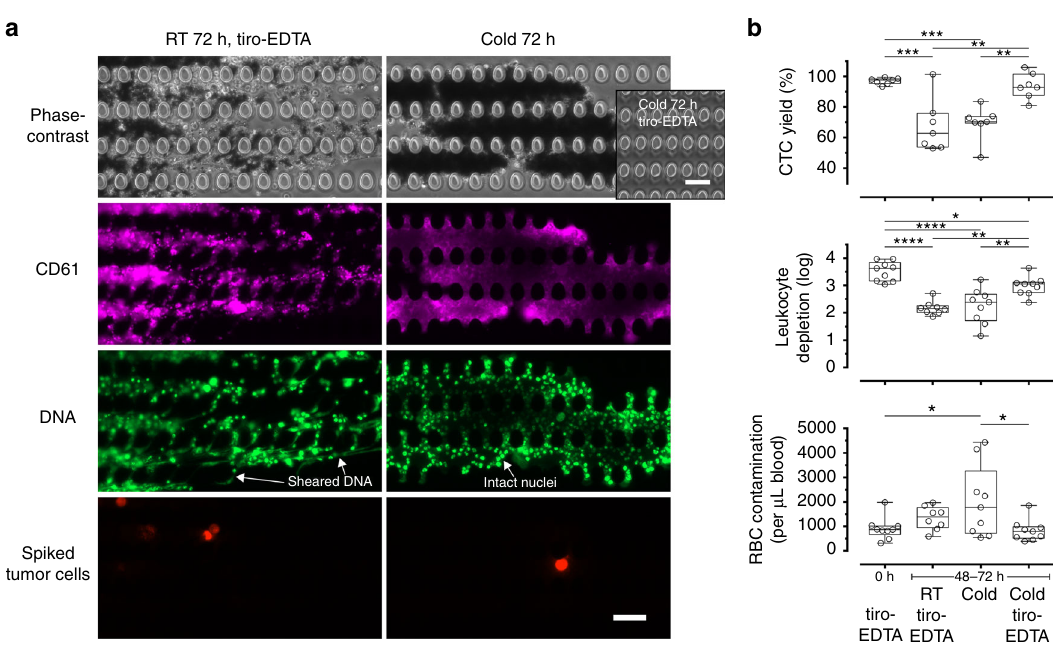
Fig. 3 Functional operation of micro fl uidic CTC isolation requires stabilized whole blood. a Representative images of the micropost array that performs size-based sorting (debulking) in the CTC-iChip. Blood storage in room temperature, even if treated with tiro-EDTA, results in aggregates that contain sheared DNA consistent with cell death and extracellular trap formation. Cold storage without tiro-EDTA leads to clots that contain densely packed platelets (CD61 staining) and intact cells. In both cases, rare cells are trapped within the aggregates. Cold storage with tiro-EDTA consistently permits clean processing (inset). b CTC isolation performance of the CTC-iChip in different storage conditions. All scale bars represent 50 μ m. Box-and-whiskers plots show median, interquartile range, maxima, and minima. * p < 0.05; ** p < 0.01; *** p < 0.001; **** p < 0.0001 (one-way ANOVA followed by Tukey ’